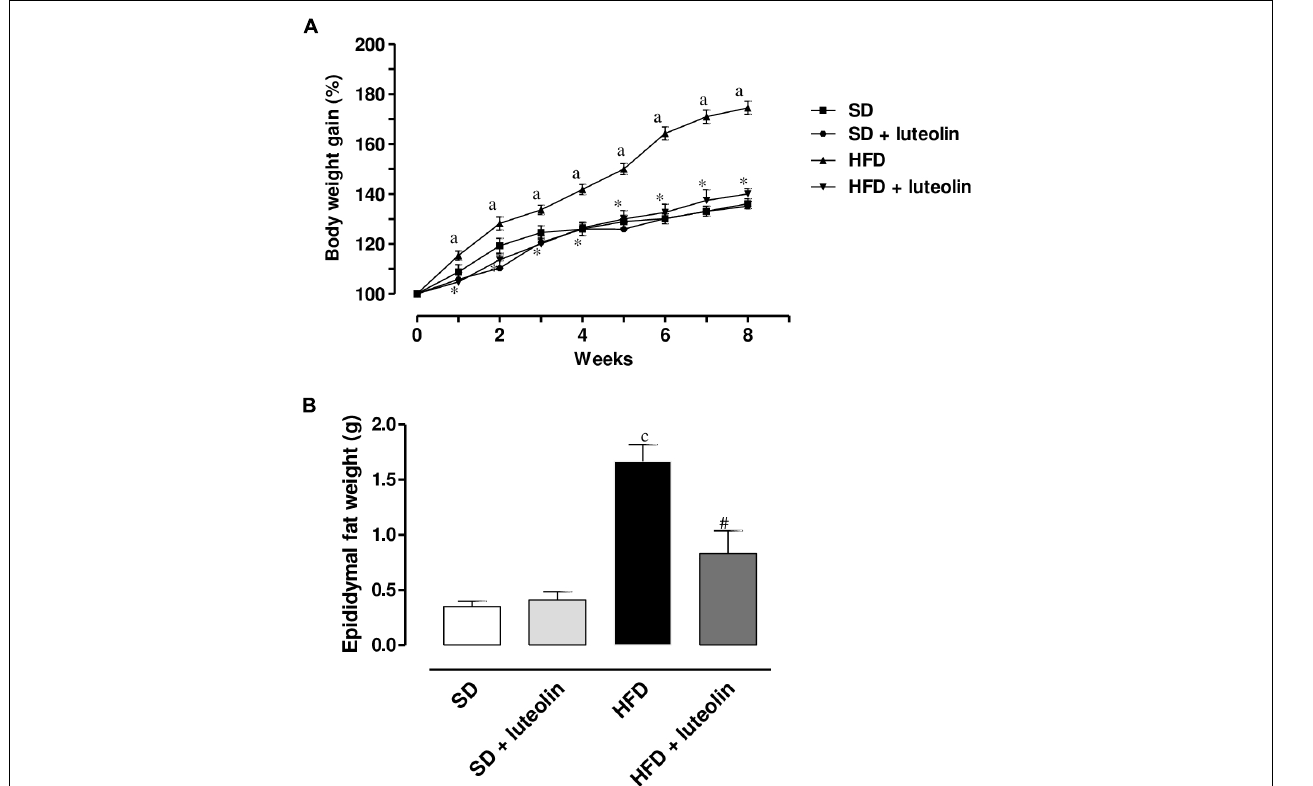
FIGURE 1 | (A) Body weight gain (%) in mice fed with SD, SD plus treatment with luteolin (10 mg/Kg/day), HFD or HFD plus treatment with luteolin (10 mg/Kg/day) for 8 weeks. Each point represents the mean ± SEM of five animals. a P < 0.05 significant difference vs. SD at the respective week; ∗ P < 0.05 significant difference vs. HFD at the respective week. (B) Epididymal fat weight in mice fed with SD, SD plus treatment with luteolin (10 mg/Kg/day), HFD or HFD plus treatment with luteolin (10 mg/Kg/day) for 8 weeks. Each column represents the mean ± SEM of five animals. c P < 0.001, significant difference vs. SD; # P < 0.001 significant difference vs. HFD. Statistics: two-way analysis of variance followed by Newman–Keuls